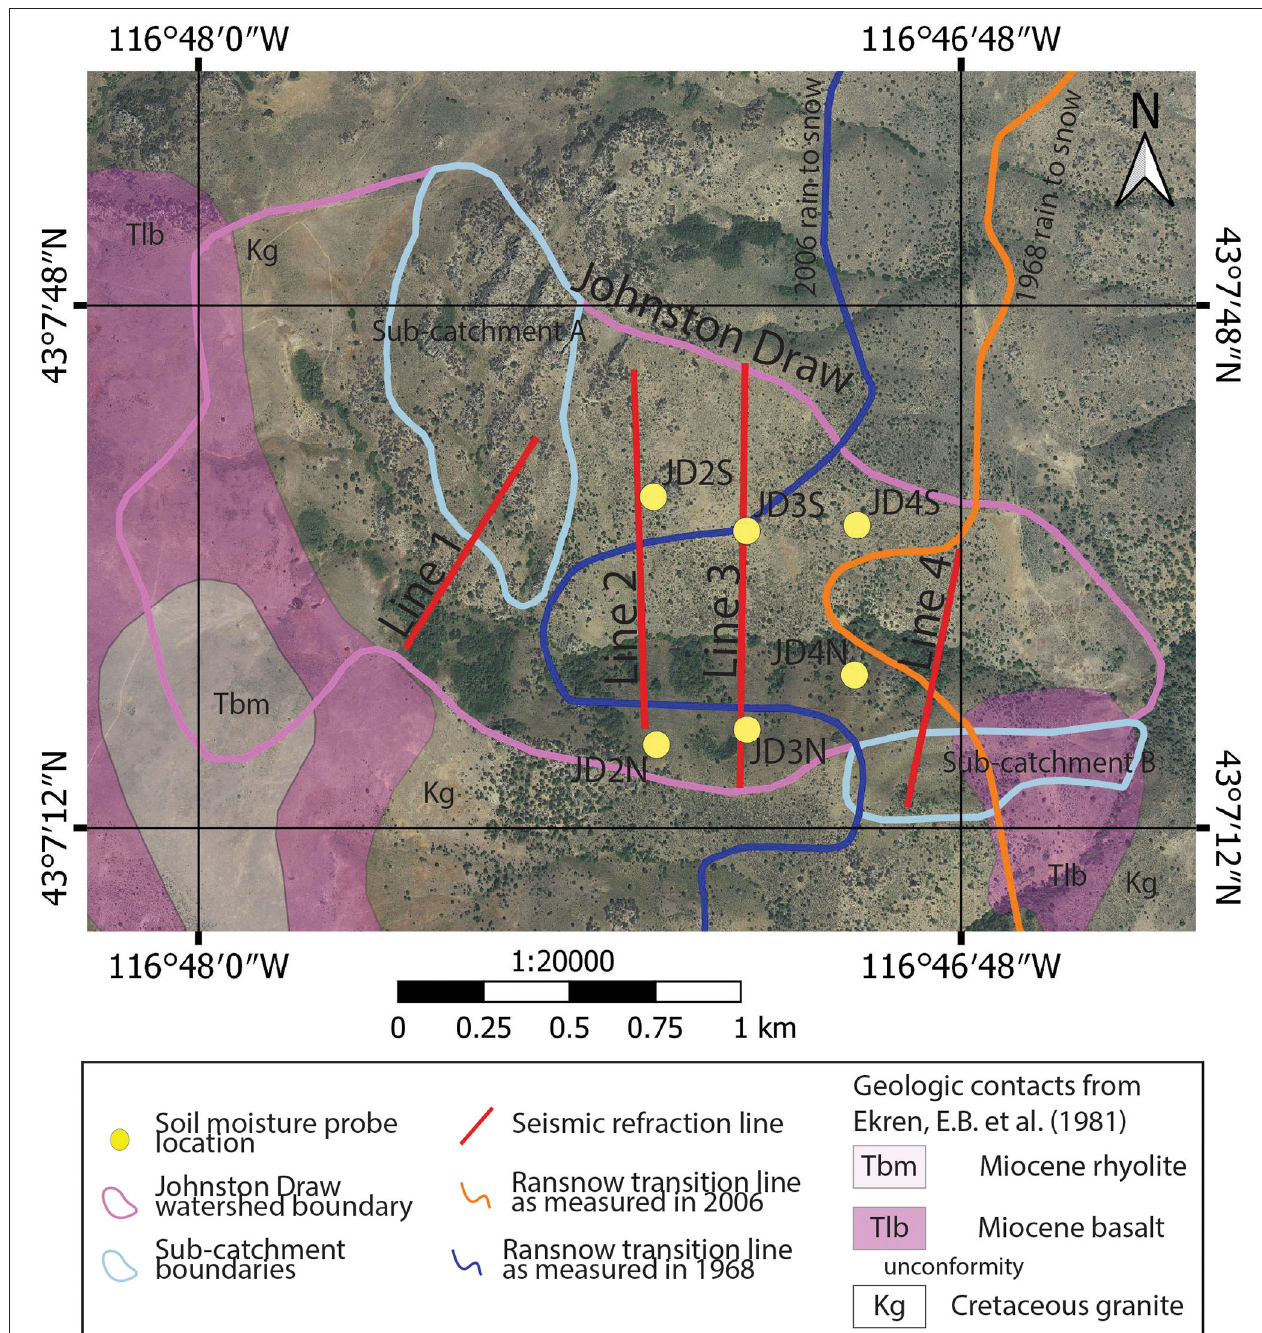
FIGURE 2 | Satellite map of the Johnston Draw watershed seismic survey in the Reynolds Creek Critical Zone Observatory. The yellow circles are the locations of the soil moisture, snow depth and soil temperature paired instrument ( Figures 3 , 4 , 11 ) sites, and the red lines are the locations of the seismic surveys ( Figures 7 , 8 ). Also shown are: the 1968 and 2006 rain/snow transition as blue and green lines, respectively, and the outlines of the Johnston Draw watershed and sub-catchments A and B. The pink areas are the surficial exposures of volcanic rock and the transparent areas granitic rock. Note that the numbering of the paired instrument sites is reversed of the numbering used by the RCCZO (Godsey et al.,